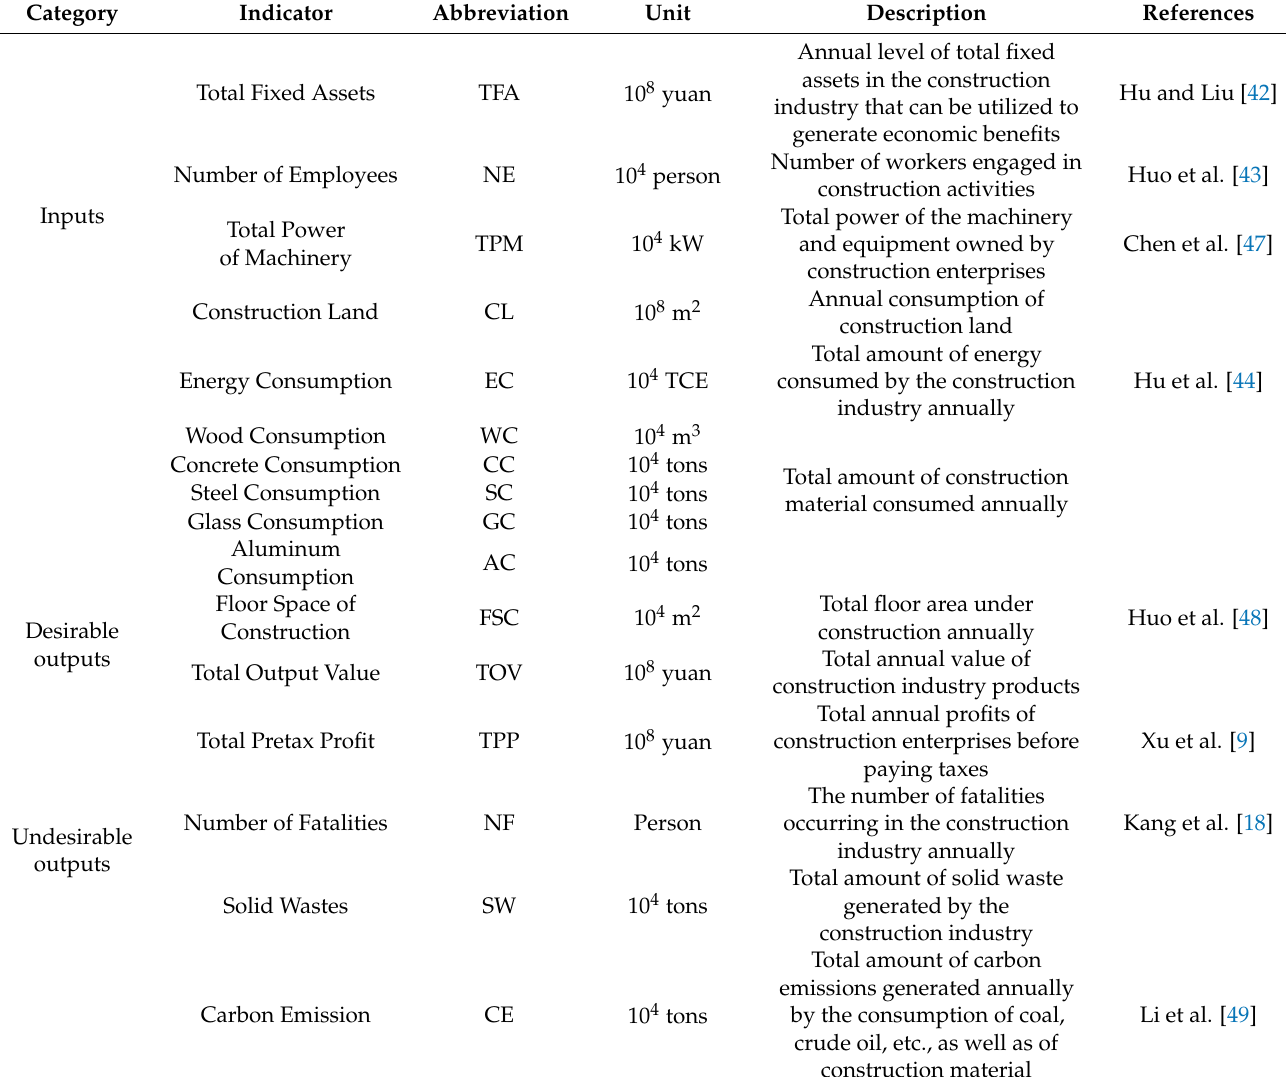
Table 1. Input-output system for assessing the regional sustainability of the construction